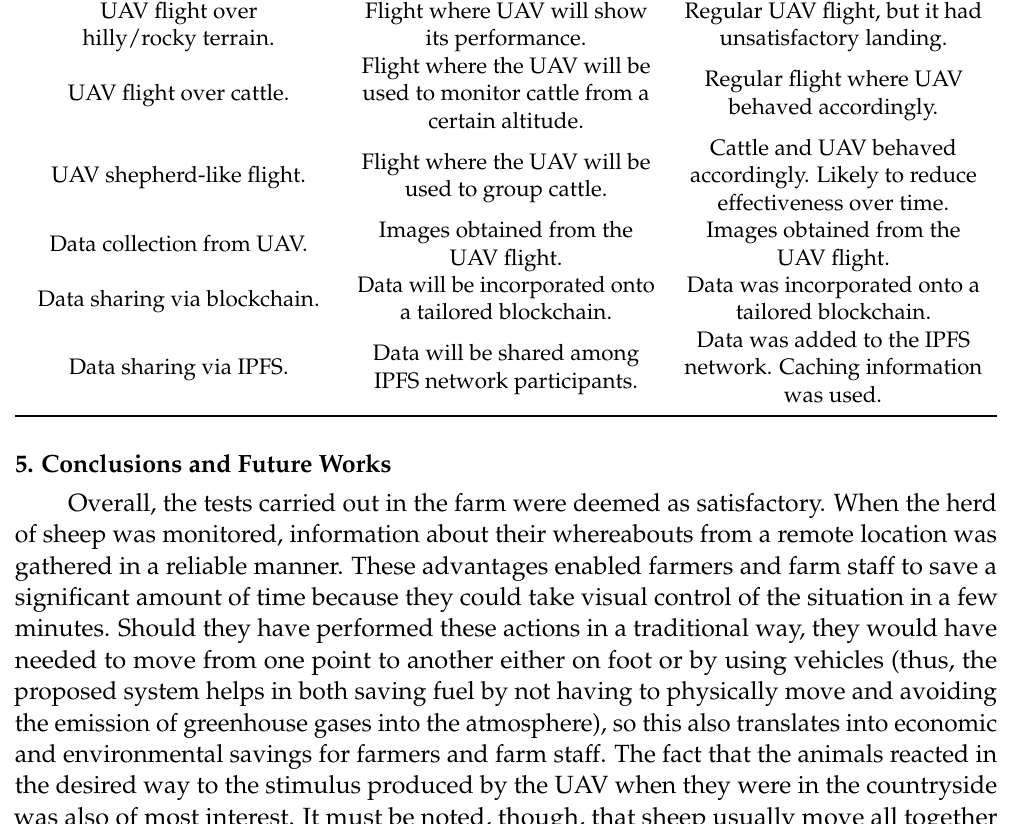
Table 8. Experiments performed and comparison between expected and obtained results. Experiment Performed Expected Result Obtained Result. Deviations Flight where UAV will show Regular flight where UAV UAV flight over flat terrain. its performance. behaved accordingly. UAV flight over Flight where UAV will show Regular UAV flight, but it had hilly/rocky terrain. its performance. unsatisfactory landing. Flight where the UAV will be Regular flight where UAV UAV flight over cattle. used to monitor cattle from a behaved accordingly. certain altitude. Cattle and UAV behaved Flight where the UAV will be accordingly. Likely to reduce UAV shepherd-like flight. used to group cattle. effectiveness over time. Images obtained from the Images obtained from the Data collection from UAV. UAV flight. UAV flight. Data will be incorporated onto Data was incorporated onto a Data sharing via blockchain. a tailored blockchain. tailored blockchain. Data was added to the IPFS Data will be shared among Data sharing via IPFS. network. Caching IPFS network participants.